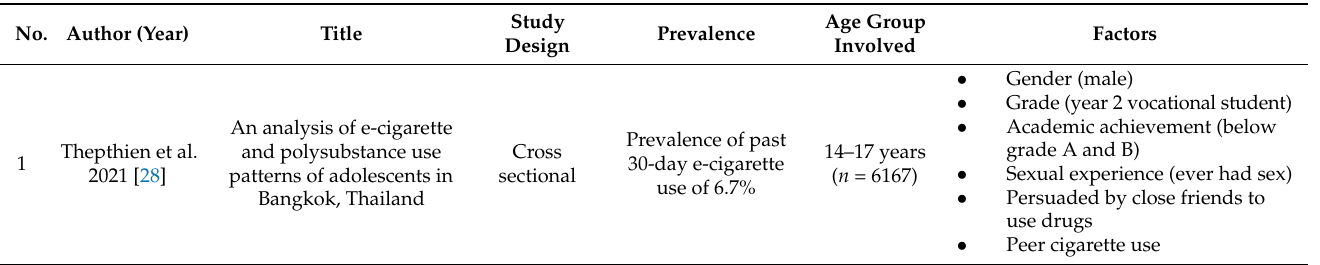
Table 2. Summary of study location and design.